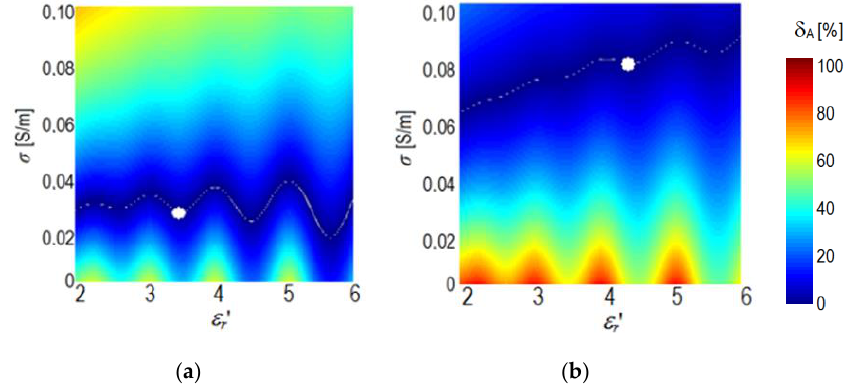
Figure 15. An example of the variability of the relative error of approximated ε r ’ and σ for the 1w_B30 model ( f = 5 GHz) with the initial assumption: ( a ) σ FDTD = 0.01 S / m, ( b ) σ FDTD = 0.02 S / m.